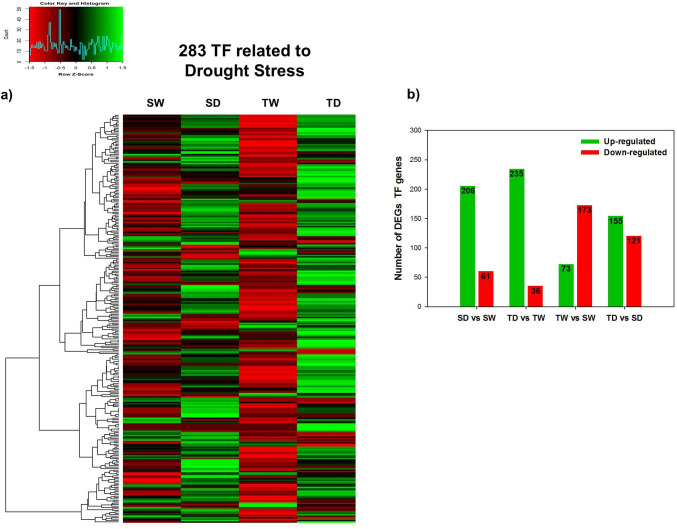
DEGs analysis in both C. papaya genotypes under well-watered or WDS conditions.Hierarchical clustering of 283 transcripts of TF genes identified in the papaya transcriptome of both genotypes when well-watered (SW and TW) or when exposed to WDS for 14 d.p.t. (SD and TD). Red indicates down-regulated, green indicates up-regulated and black unchanged values, as shown on the color scale at the side of the figure a). Comparison of the DEGs number of 283 TF genes evaluated by up- and down-regulated in the papaya transcriptome of both genotypes, when well-watered (SW and TW) or when they were exposed to WDS for 14 d.p.t. (SD and TD) b).